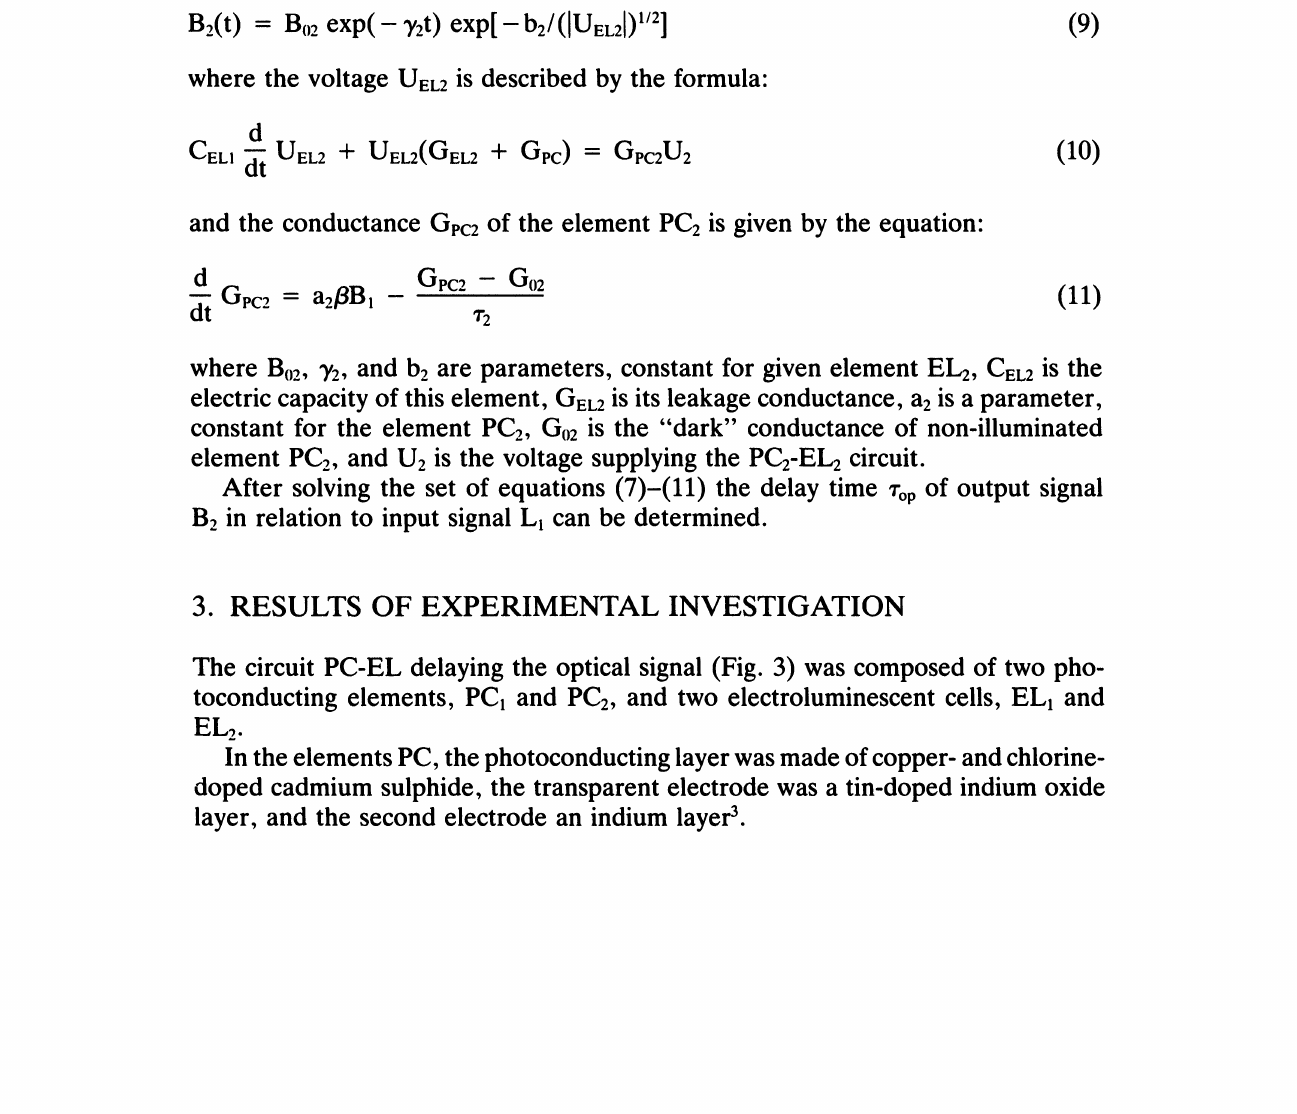
FIGURE 3 Thin film PC-EL type optical signal delaying